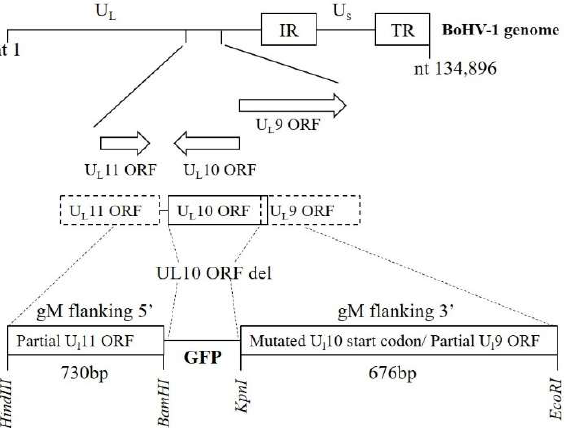
Figure 1. Schematic of the plasmid constructed for deletion of the U L 10 gene. On top, the BoHV-1 genome consisting of unique long (UL) and unique short (US) regions along with internal repeats (IR) and terminal repeats (TR) is depicted. The localization of U L 9, U L 10 (gM), and U L 11 genes is shown. In the constructed plasmid, the gM gene is deleted and GFP is inserted in that position with the insertion of BamH I and Kpn I sites. The GFP was flanked with a 730bp 5 ′ gM flanking region and 676 bp 3 ′ gM flanking region along with a mutated start codon for U L 10. Table 2. Primer list for construction of ΔgM BoHV-1 and ΔgM Rev BoHV-1 recombinant viruses.